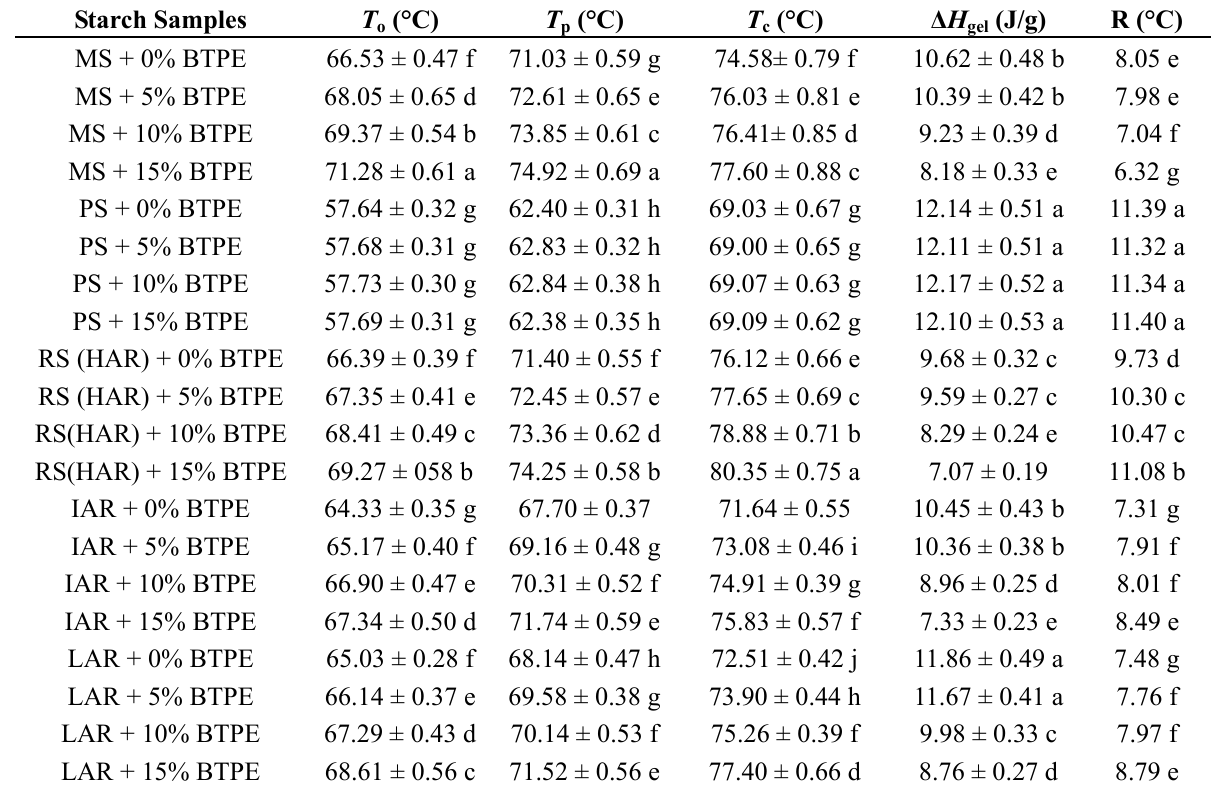
Table 3. Gelatinization thermal properties of the mixtures of different starch samples and black tea polyphenol extract (BTPE) at various